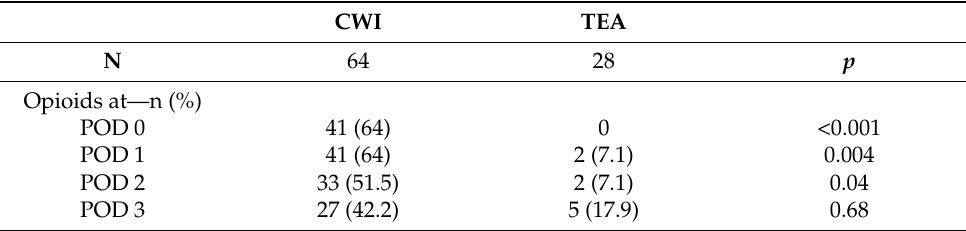
Table 3. Ratio of patients received a strong opioid (either per os, subcutaneously or intravenously) in days following surgery reported for two groups compared with χ 2 test.